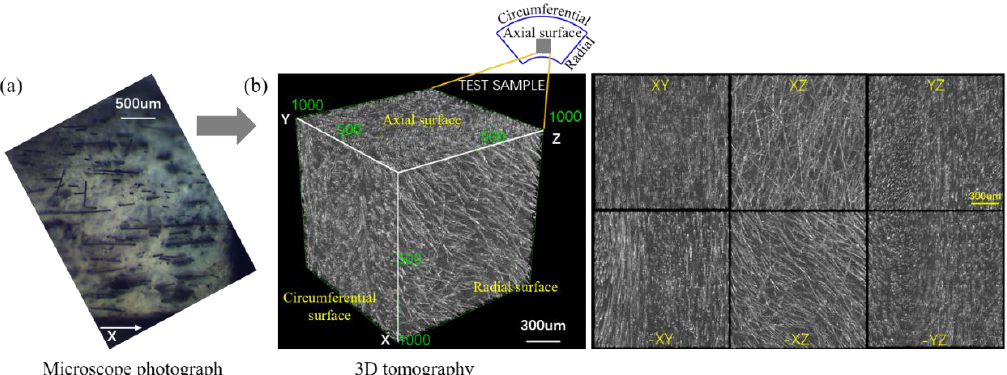
Figure 13. Micromorphology of reclaimed carbon fiber (RCF)/PP: ( a ) Micrograph in cross-section of RCF/PP; ( b ) A 3D representation of the individual fibers in the matrix, Voxel size was (1.48 μm).